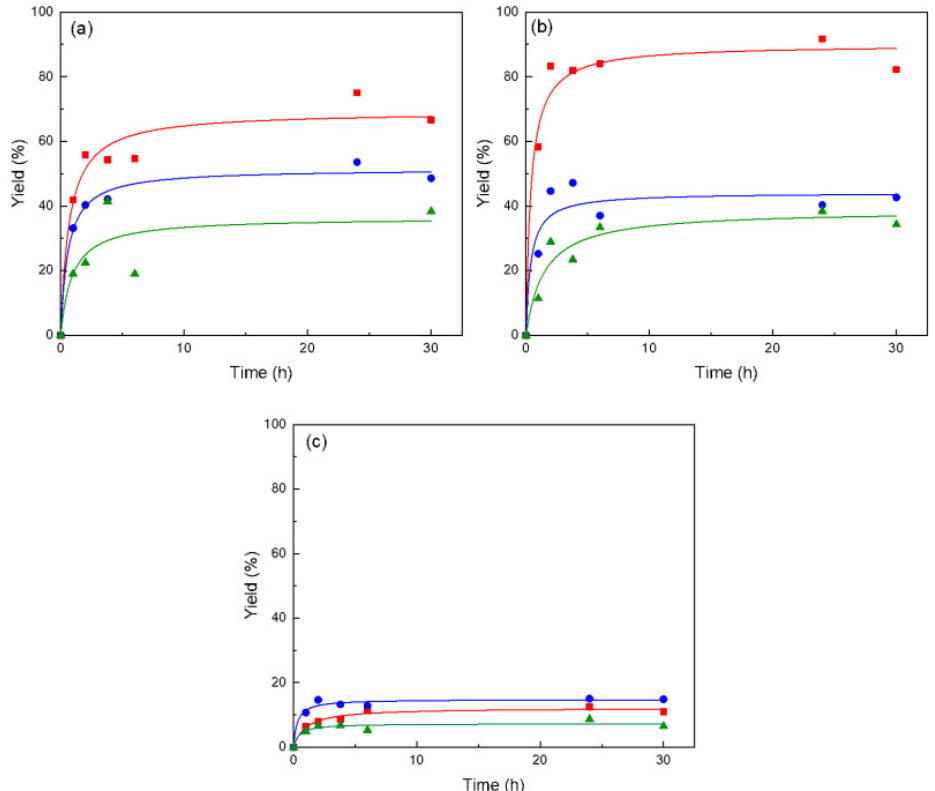
Figure 3. Effect of solvent and temperature on the synthesis of ascorbyl palmitate catalyzed by Lipozyme 435. Solvents: 2-methy-2-butanol ( a ), acetone ( b ) and ter-butanol ( c ). Temperatures: 45 ◦ C ( (cid:78) ), 50 ◦ C ( • ) and 55 ◦ C ( (cid:4) ). Reactions were carried out in 5 mL solvent media at substrate ratio 1:8, with 60 mg ascorbic acid added in two steps (time 0 h and after 4 h). Other reactants added were 698 mg palmitic acid, 60 mg Lipozyme 435, and 180 mg molecular sieve.